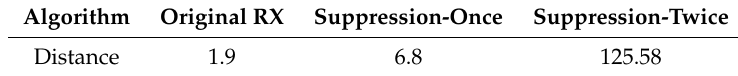
Table 2. Distance between target and background by using the nonlinear suppression function. Algorithm Original RX Algorithm